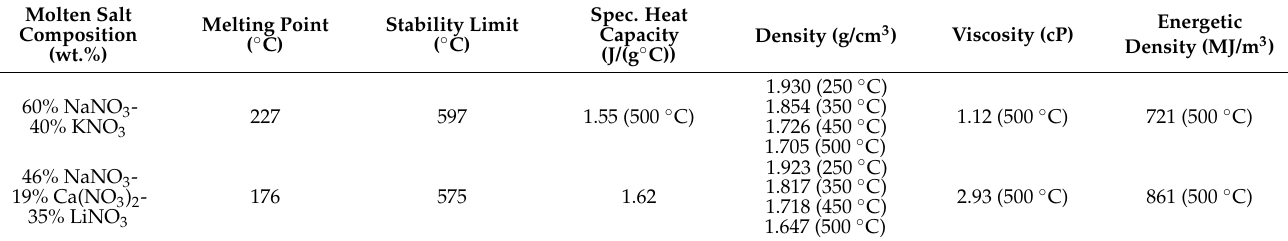
Table 2. Physicochemical properties of the studied molten